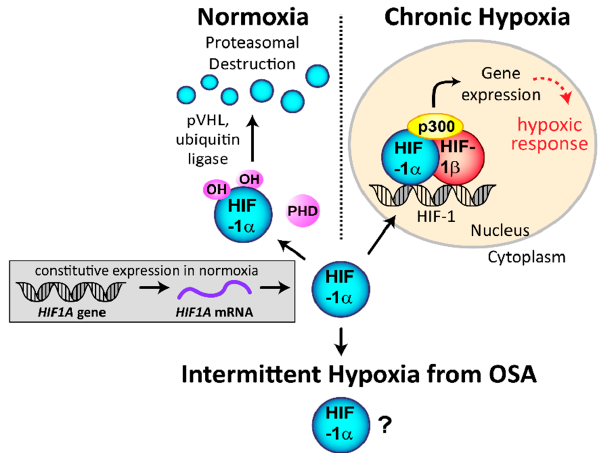
Figure 1. Regulation of hypoxia inducible factor-1 α (HIF-1 α ) stability and HIF-1